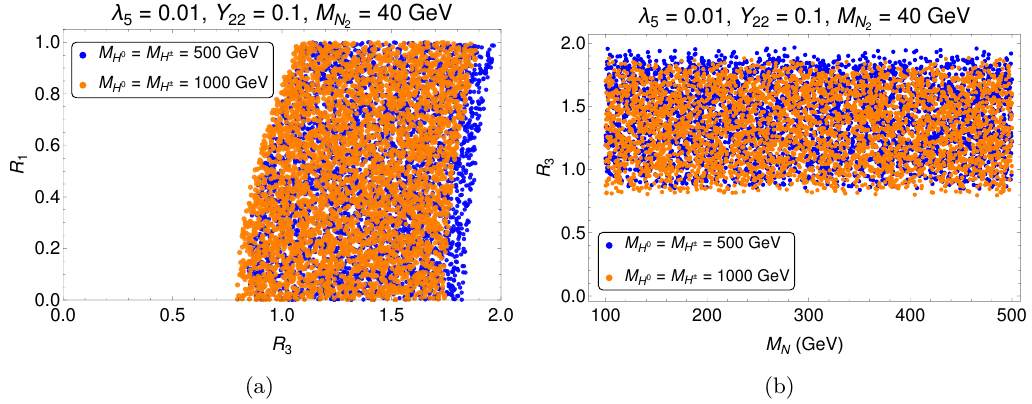
Figure 12 . In the left plot, the region bounded by the points is the parameter space of R 1 and R 3 that satisfies R ( D ) , R ( D ∗ ) and B ( ¯ B → D ( ∗ ) ‘ ¯ ν ‘ ) constraints in their 2 σ CL and B ( B c → τν ) < 30% for M = 500 GeV (blue) and M = 1000 GeV (orange). The other relevant parameters have H ± H ± been fixed as shown in the plot label. The correlation between R 3 and M N is shown in the right